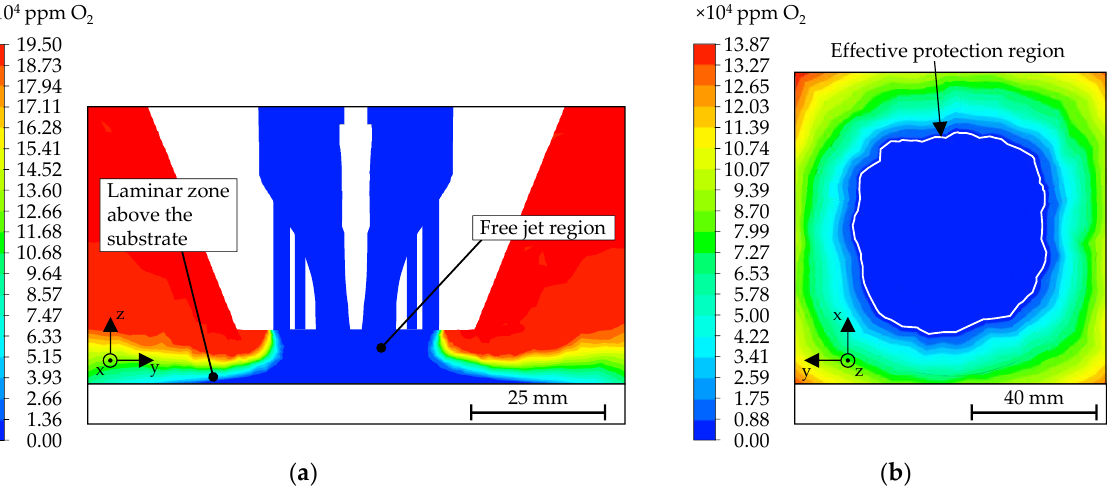
Figure 6. Contour plots of the oxygen distribution at a shielding gas flow of 50 l/min: ( a ) outlet of the optimized shielding gas nozzle as a cross-sectional view; ( b ) oxygen map on the substrate plane. In order to reliably avoid unacceptable oxidation during the process, the dimensions of the area sufficiently covered with shielding gas are relevant. This area is referred to as the “effective protective region” [25]. For the processing of titanium in DED processes, the effective protection region was defined by Ding et al. [28] as well as Li et al. [25] as the area in which the oxygen concentration was below 2000 ppm. Although stainless steel is less critical than titanium in terms of the maximum acceptable oxygen concentration, this value was used as a conservative limit in the simulations. The effective protection region is indicated in Figure 6b. To evaluate the shielding effect based on CFD simulations, the flow rate was varied between 5 l/min and 100 l/min in steps of 5 l/min. To quantify the